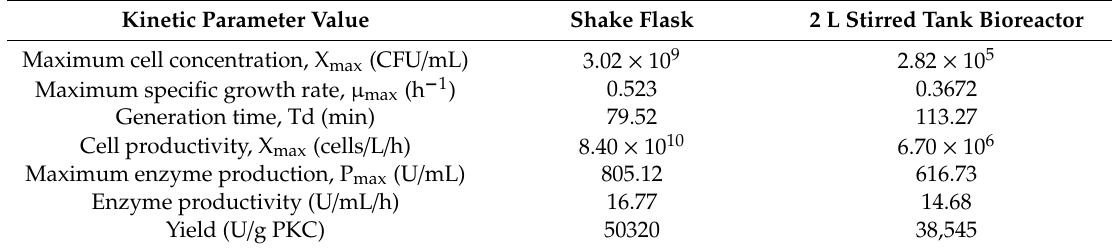
Table 7. The performance of cell growth and β -mannanase production by B. subtilis fermentation in shake flask and 2 L stirred tank